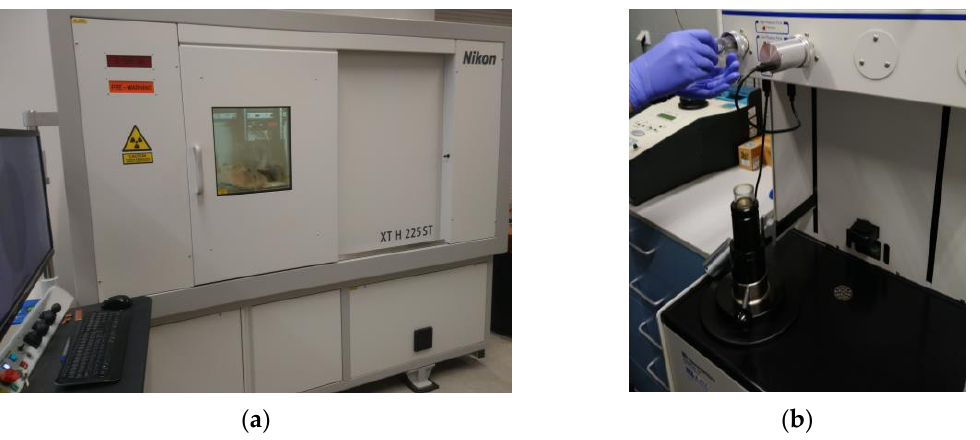
Figure 3. Basic devices used to measure the porosity of traditional silicate materials and those modified with glass sand: ( a ) Nikon XT H 225 ST computer tomograph; ( b ) QUANTACHROME ULTRAPYC 1200e mercury